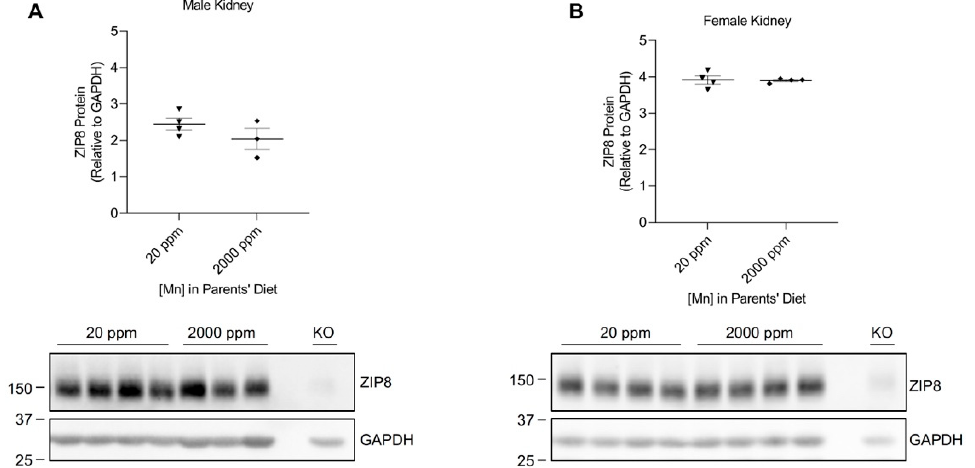
Figure 3. Comparison of ZIP8 levels in the kidney between the control and high-manganese diet groups. Kidney samples were collected from pups at 3 weeks of age for Western blot analysis. Expression of ZIP8 in male ( A ) and female ( B ) pups that were born from and fed by mothers on 20 ppm manganese and 2000 ppm manganese diets were compared ( n = 3–4/group). Samples with equal amounts of protein (159 µg) were analyzed. Blots include the kidney sample from a female, 6-week-old Zip8 -KO mouse (fed a traditional rodent diet) as a control. Quantification of ZIP8 levels were determined using GAPDH as the loading control. Data are expressed as mean ± SEM.